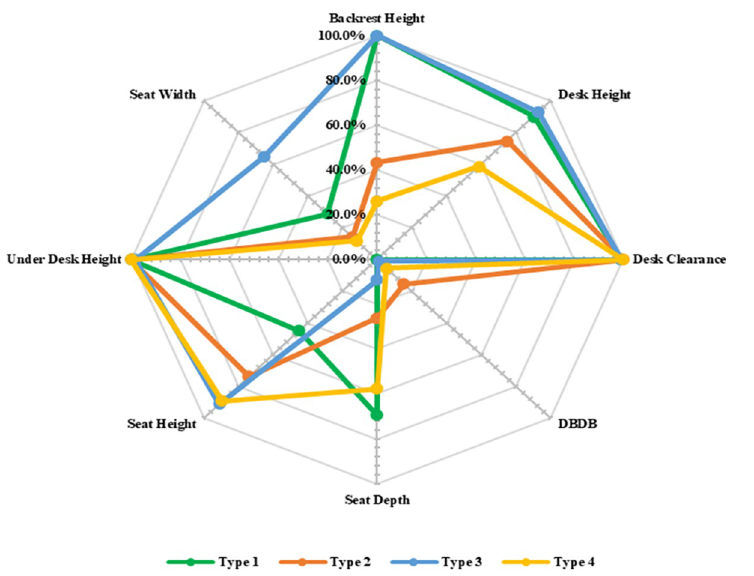
Fig 7. Radar chart of match percentages considering the type of furniture.